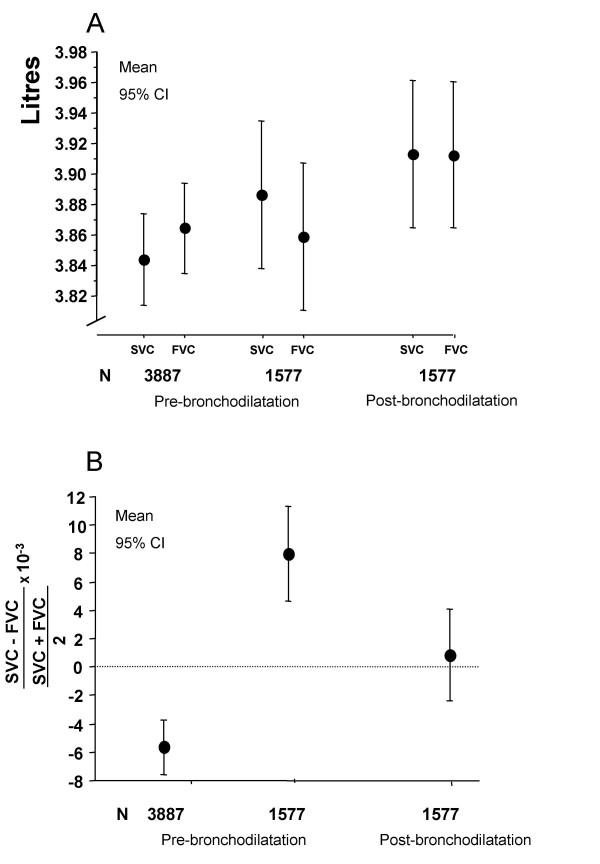
A. Slow (SVC) and forced vital capacity (FVC) before bronchodilatation in 3887 smokers and pre- and post-bronchodilatation in 1577 smokers with a pre-bronchodilator FEV1/VC-ratio below 0.75. B. The difference between SVC and FVC corrected for VC-level in the same smokers as in panel A.